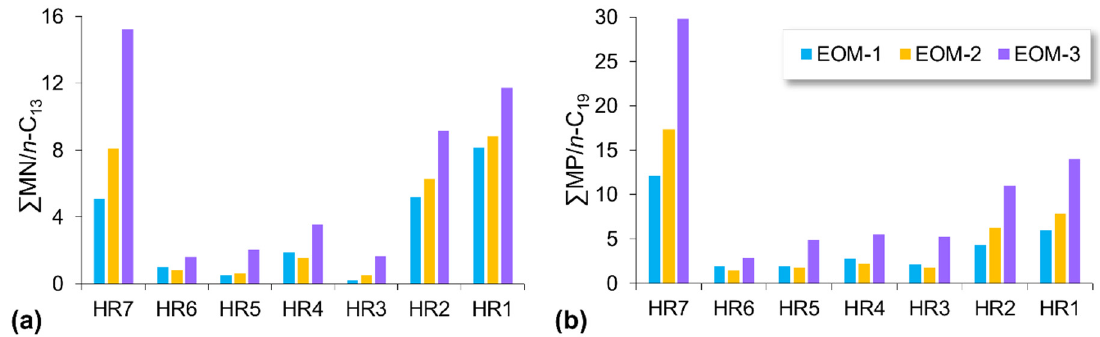
Figure 11. The ratios of representative aromatic hydrocarbons to saturated hydrocarbons in sequential extracts of samples HR1-HR7: ( a ) ∑ MN/ n -C 13 ; ( b ) ∑ MP/ n -C 19 .